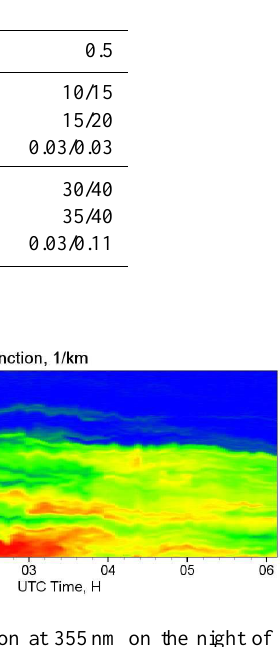
Table 1. Uncertainties of effective radius ( ε reff ) , volume density ( ε V ) and the real part of CRI ( ε mR ) retrieval with regularization and LE approaches from 3 β + 2 α /3 β + 1 α data sets.